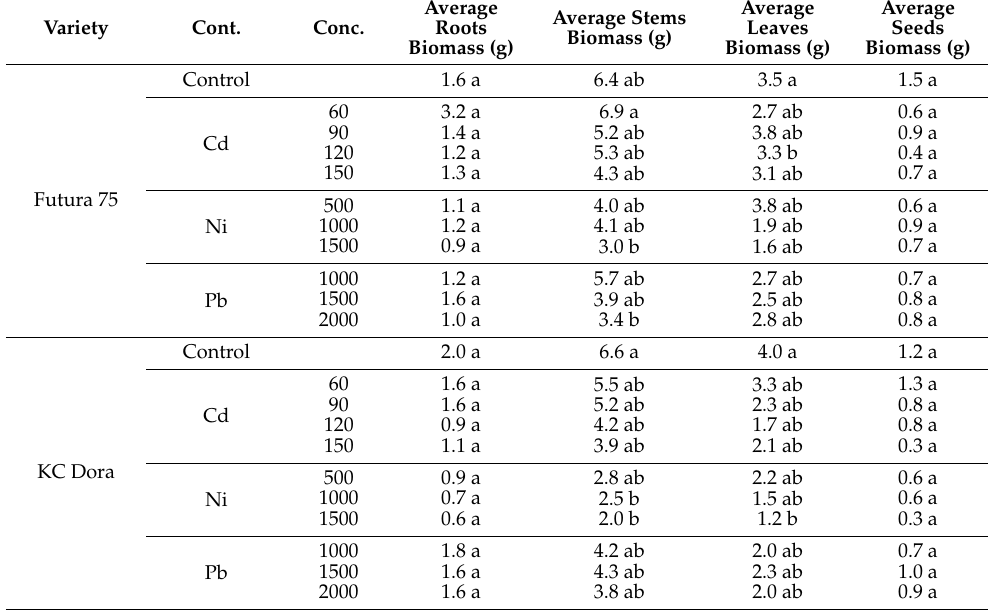
Table 5. Average of the weight of the different compounds of the biomass (roots, stems, leaves, and seeds) in relation to different contaminants and concentrations. The multiple comparisons were performed within the fractions of the plants. Different letters indicate significant differences between the means (according to HSD at p ≤ 0.05). Variety Cont. Conc.